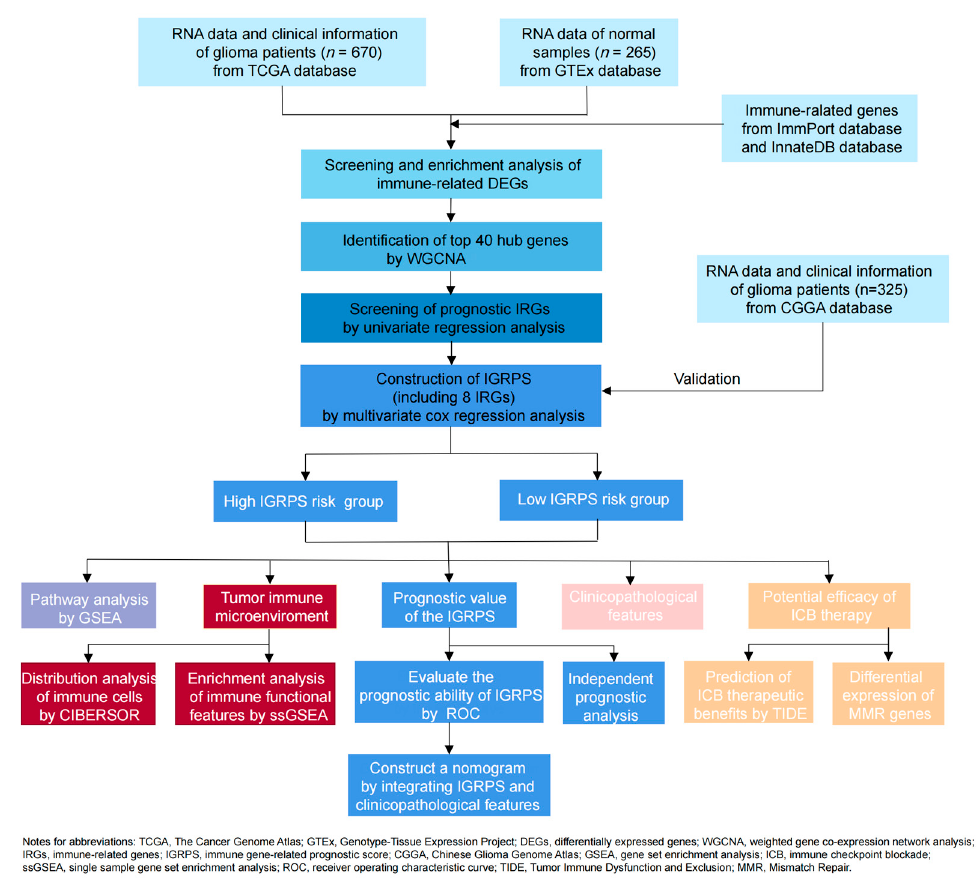
Figure 1. Flow chart.